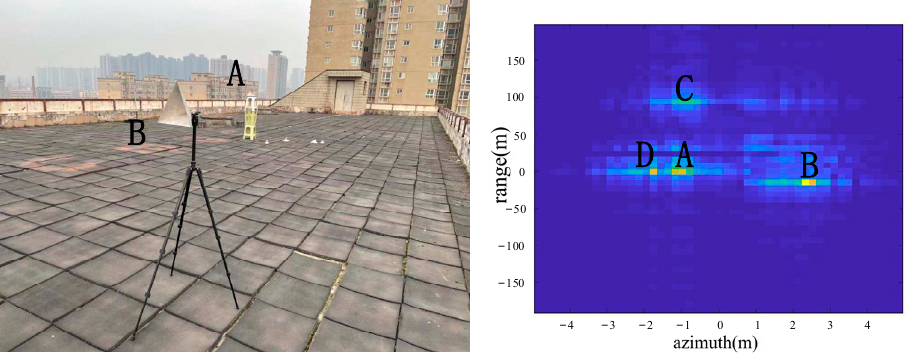
Figure 15. The 10th group of experimental scenes and imaging results. As shown in Figure 16, two corner reflectors A and B were placed in the azimuth direction 25 m from the radar. The two corner reflectors A and B were 2.5 m apart in the azimuth direction. The corner reflector A was on the left, and the corner reflector B was on the right. A and B were both big corner reflectors. According to the imaging results, the positions of A, B, C and D were consistent with the positions of objects in the actual scene. According to the simulation parameters in Table 1, the Rayleigh diffraction limit res- olution was calculated to be 29.4449 m. In this experimental scenario, the distance between the two corner reflectors of A and B was 2.5 m. Therefore, the proposed algorithm achieved more than 10 times the super-resolution capability. A B − 4 Figure 16. The 11th group of experimental scenes and imaging results.